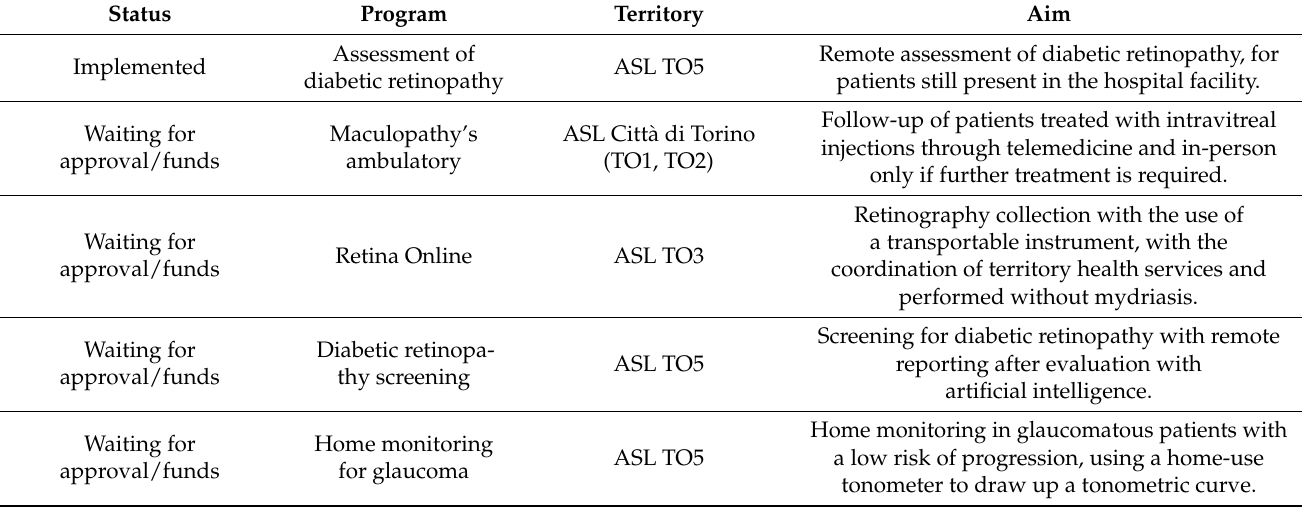
Table 1. Implemented teleophthalmology programs and programs waiting for approval and/or